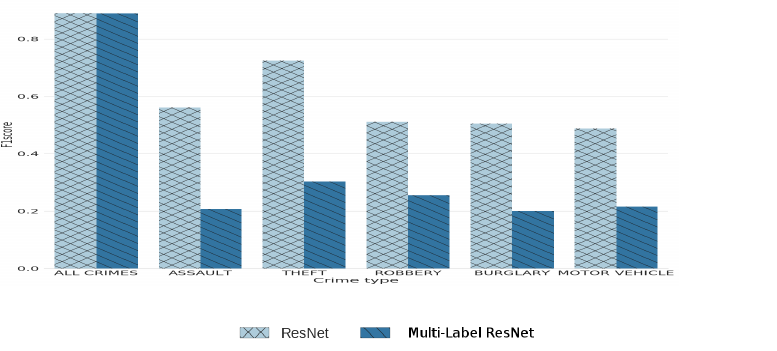
Figure 7. F1score per crime type in the Philadelphia dataset, for binary and multi-label hotspot prediction. Best viewed in